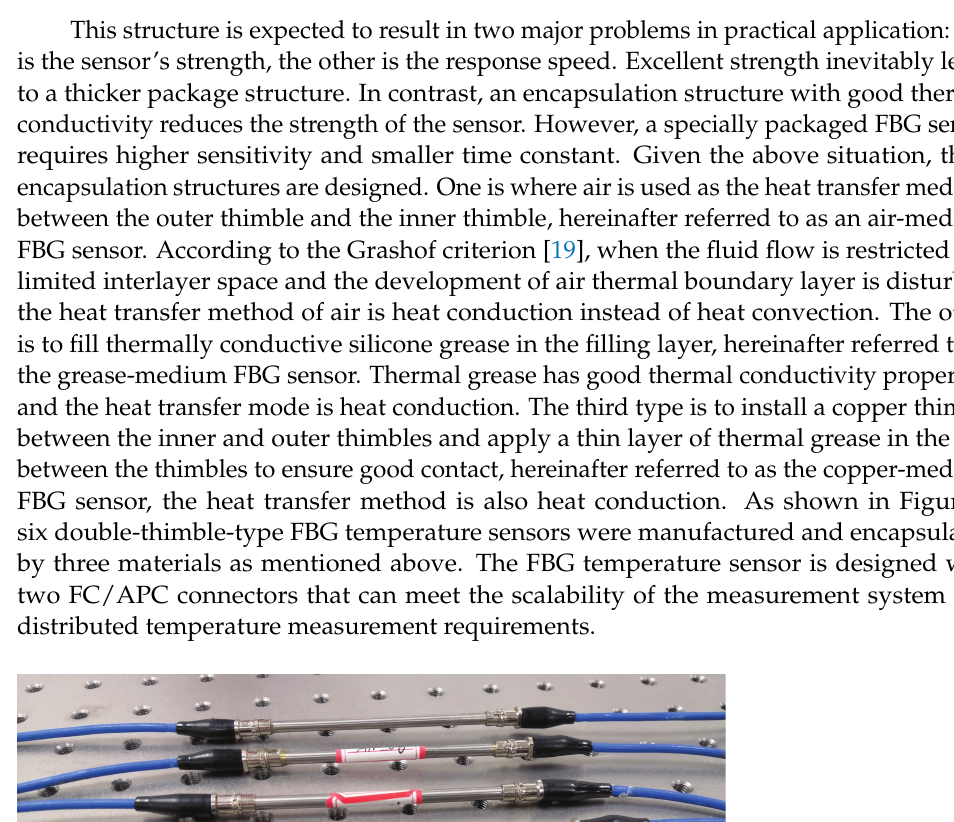
Figure 2. The structure diagram of the FBG temperature sensor.